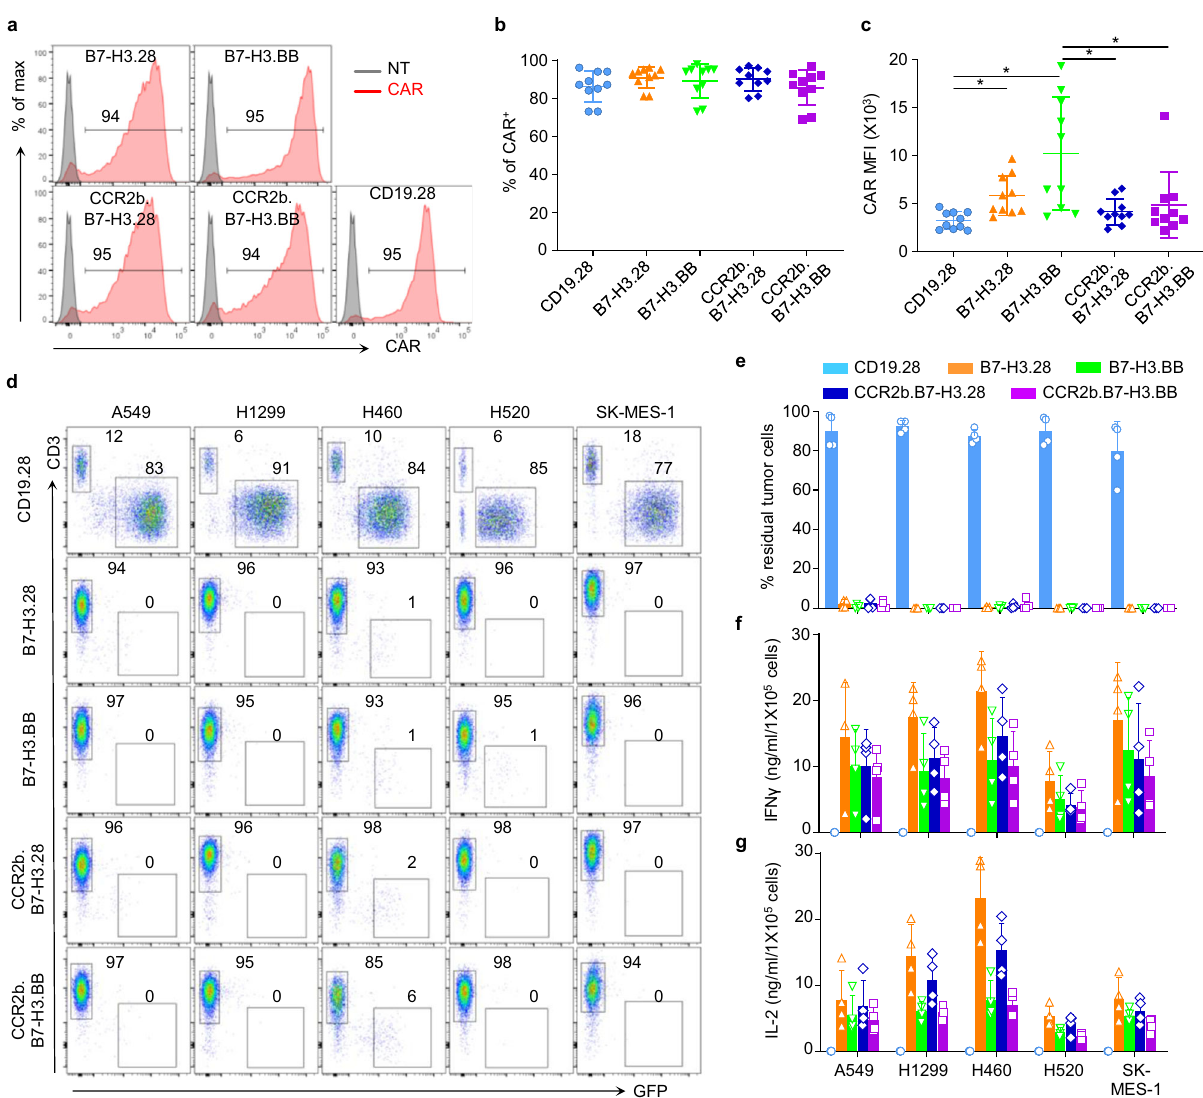
Fig. 4 CCR2b co-expressing B7-H3.CAR-T cells have comparable antitumor activity when coculture with NSCLC cell lines in vitro. a Representative fl ow plots of CARs expression in CD19.28, B7-H3.28, B7-H3.BB, CCR2b.B7-H3.28 and CCR2b.B7-H3.BB CAR-T cells as assessed by fl ow cytometry. b, c Summary of the percentage ( b ) and MFI ( c ) of CAR expression in B7-H3.28, B7-H3.BB, CCR2b.B7-H3.28 and CCR2b.B7-H3.BB CAR-T cells ( n = 10 independent experiments using CAR-T cells generated from ten different donors, * p = 0.0219 for CD19.28 vs. B7-H3.28, * p = 0.0240 for CD19.28 vs. B7- H3.BB, * p = 0.0295 for B7-H3.BB vs. CCR2b.B7-H3.28, * p = 0.0217 for B7-H3.BB vs. CCR2b.B7-H3.BB, one-way ANOVA). Data are presented as mean values ± SD. d, e GFP-labeled NSCLC cell lines were cocultured with CD19.28, B7-H3.28, B7-H3.BB, CCR2b.B7-H3.28 or CCR2b.B7-H3.BB CAR-T cells at the CAR-T cell to tumor cell ratio of 1:5. On day 5, NSCLC cells (GFP + ) and CAR-T cells (CD3 + ) were enumerated by fl ow cytometry. Representative fl ow- cytometry plots ( d ) and quanti fi cation of residual tumor cells ( e ) are illustrated. Data are presented as mean values + SD. f, g Summary of IFN γ ( f ) and IL2 ( g ) released by CAR-T cells in the culture supernatant after 24 h of coculture with the indicated cell lines as measured by ELISA, n = 4